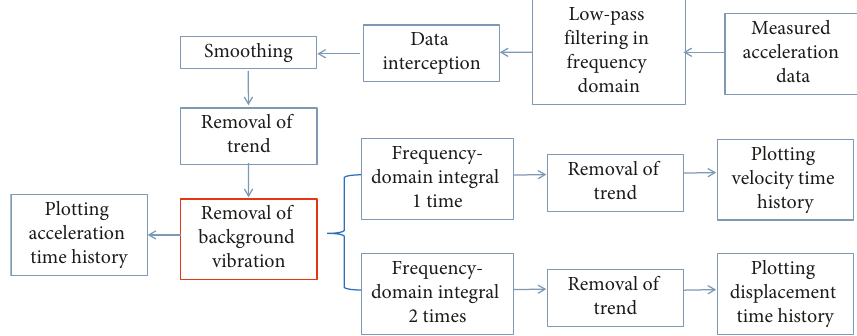
Figure 4: Preprocessing step of measured